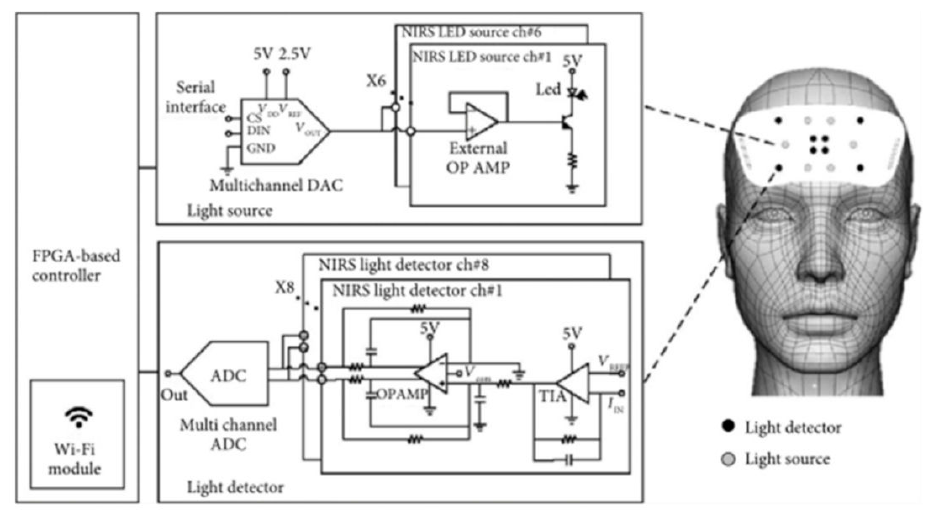
Figure 12. A proposed system for fNIRS utilizing deep forest algorithm. (Reprinted from